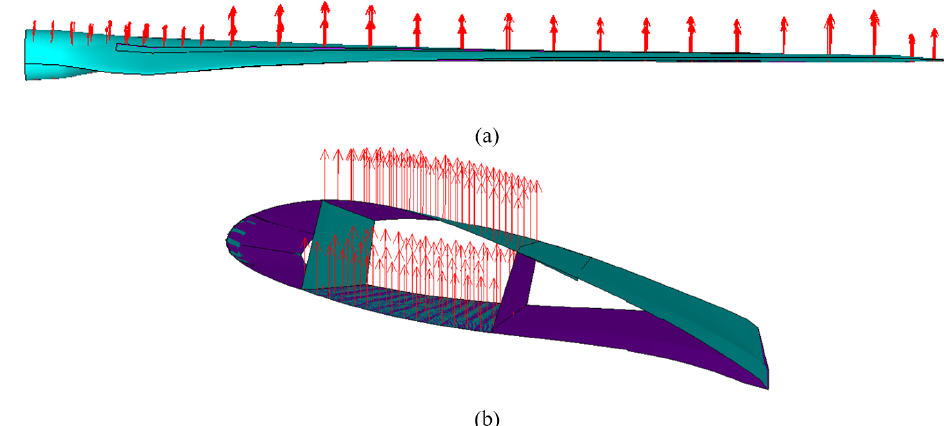
Figure 10. Extreme flapwise load application to blade FE model: (a) side and (b) cross-section view.